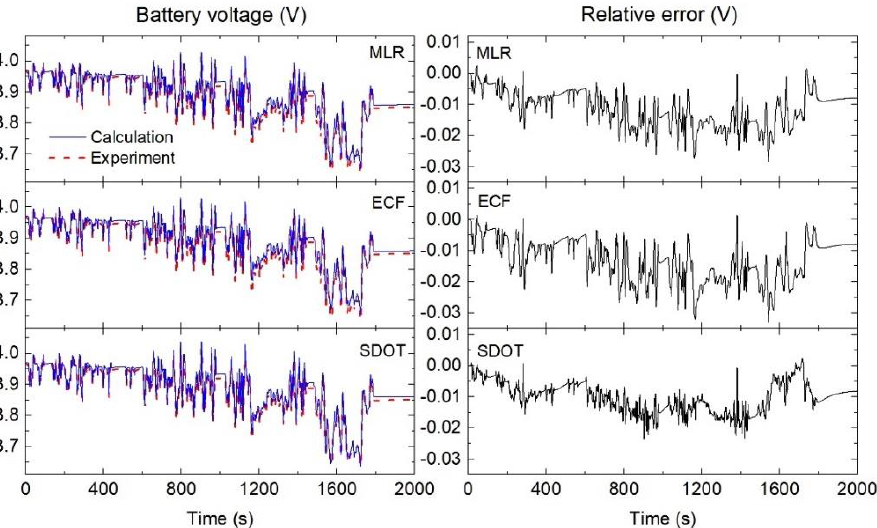
Figure 13. The battery terminal voltage of the WLTP dynamic test and the relative error for the three estimations.